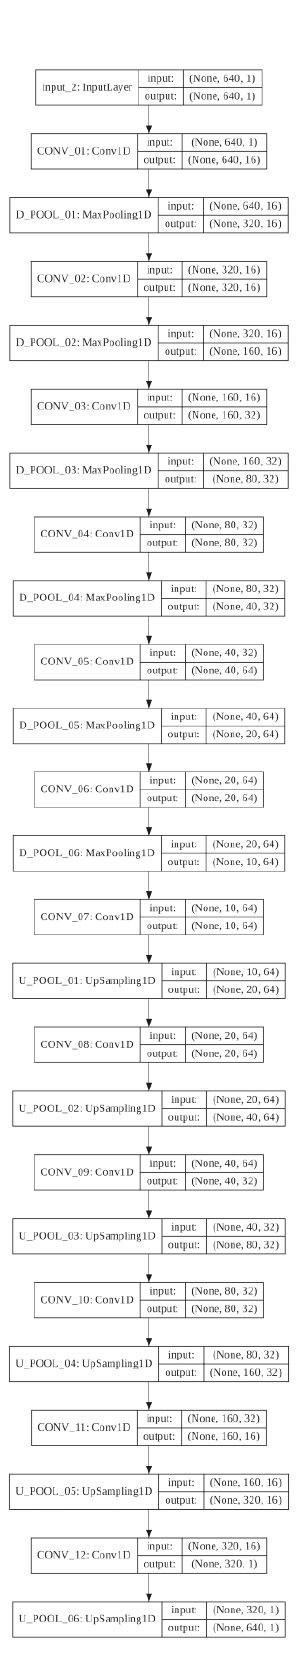
Figure (cid:3)(cid:3) A1. LeNet-5 based deep convolution autoencoder (LDCAE) structure. Figure A1. LeNet-5 based deep convolution autoencoder (LDCAE)